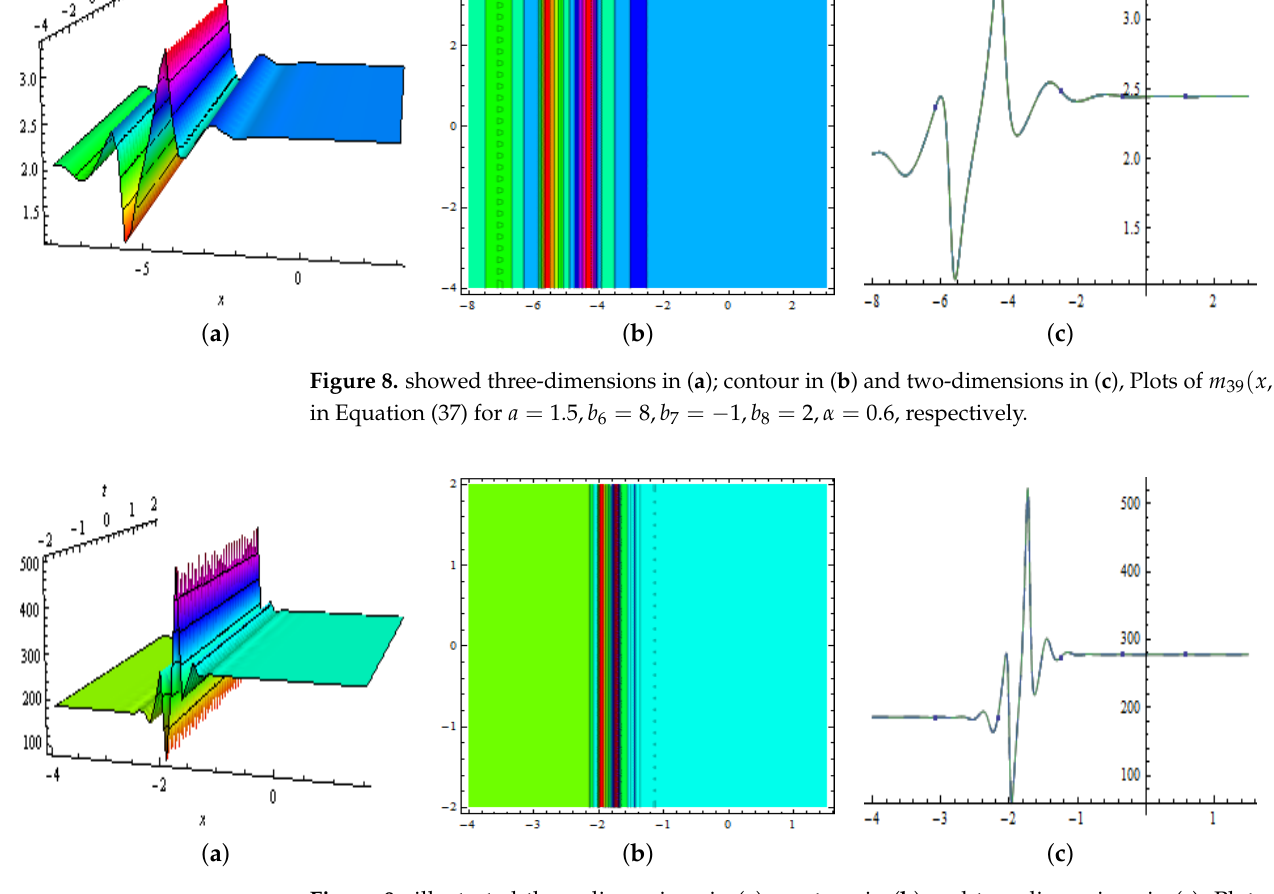
Figure 9. illustrated three-dimensions in ( a ); contour in ( b ) and two-dimensions in ( c ), Plots of n 40 ( x , t ) in Equation (37) for a = 1.3, b 6 = 7, b 7 = − 4, b 8 = − 5, α = 0.6,